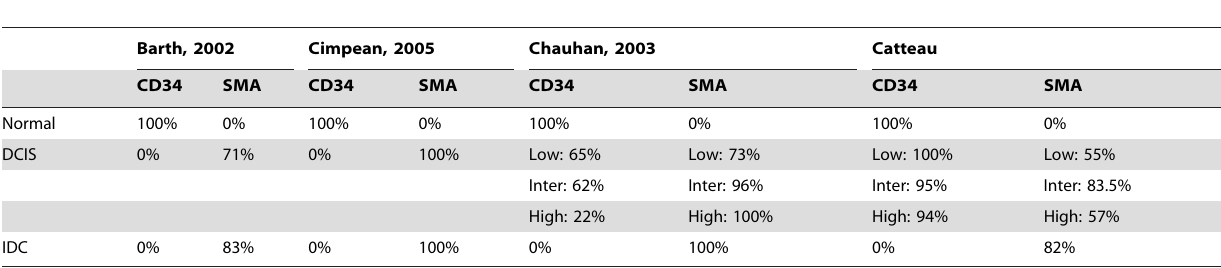
Table 3. Expression of CD34 fibrocytes and SMA myofibroblasts in DCIS and IDC: literature